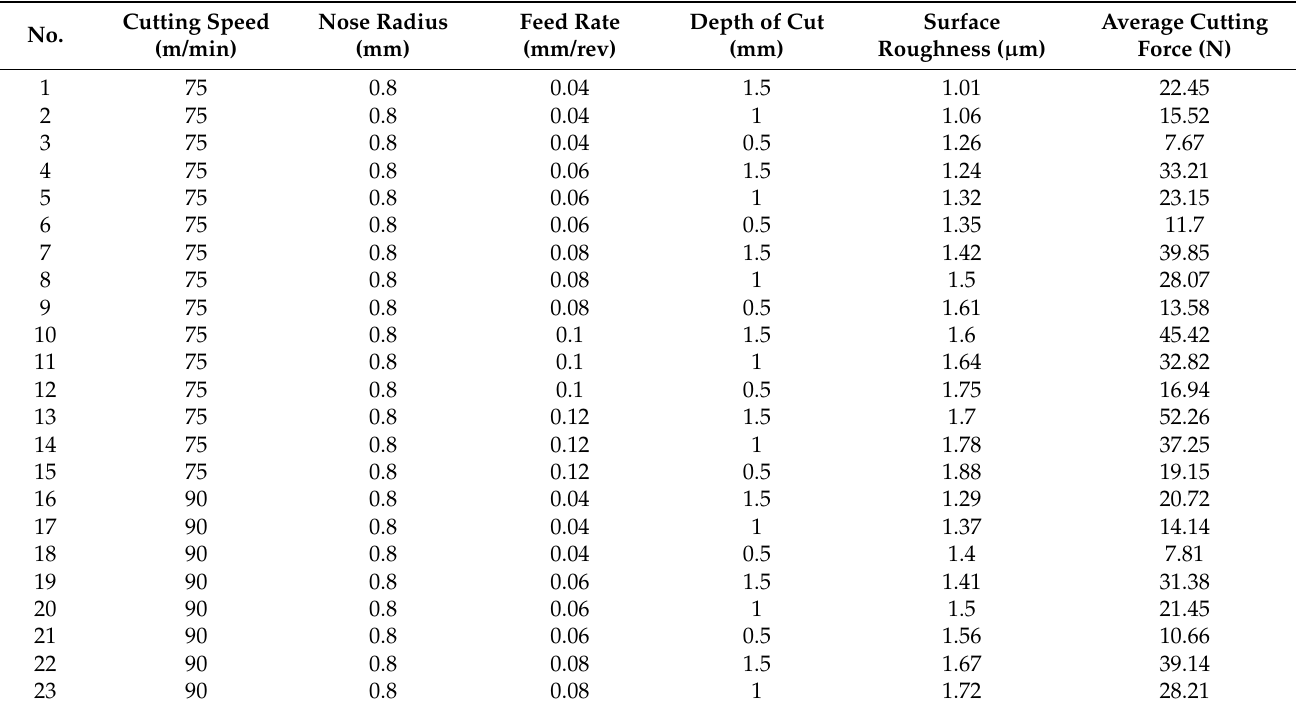
Table 2. Experimental results